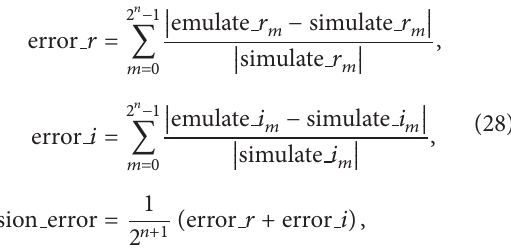
Figure 15: Fixed point representation format.